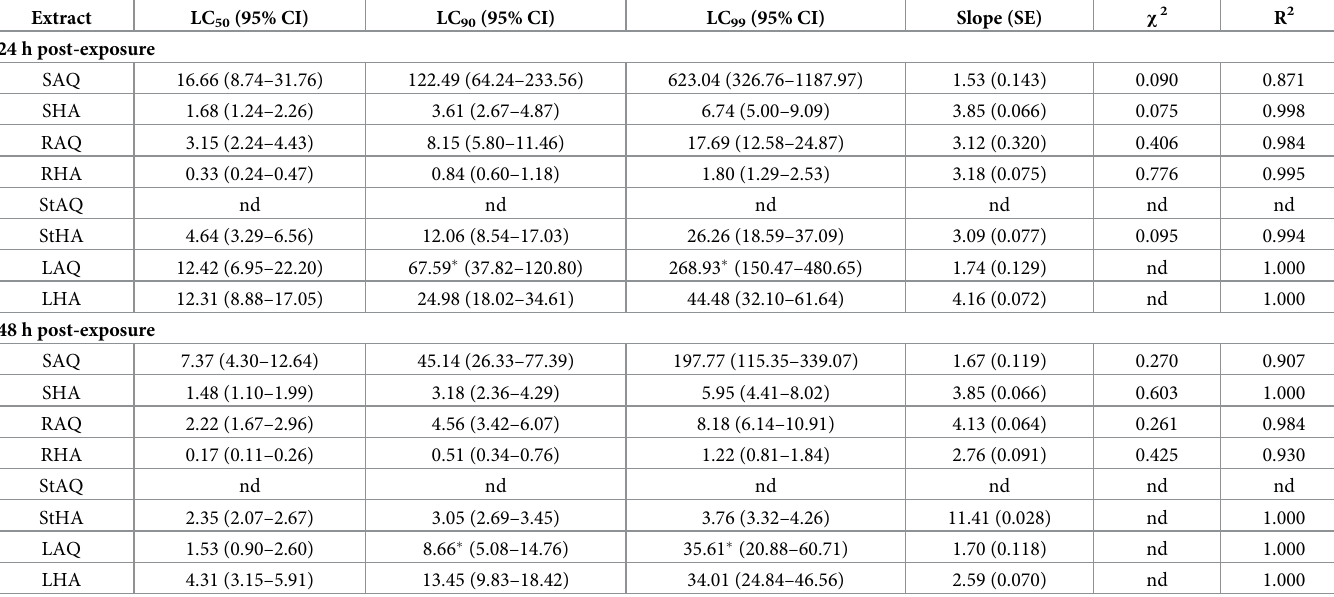
Table 2. LC 50 , LC 90 and LC 99 values for Aedes aegypti larvae (L4) exposed to Tephrosia toxicaria extracts.